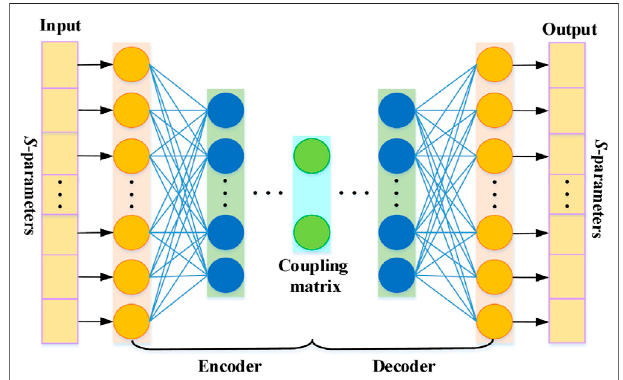
FIGURE 1 | Autoencoders